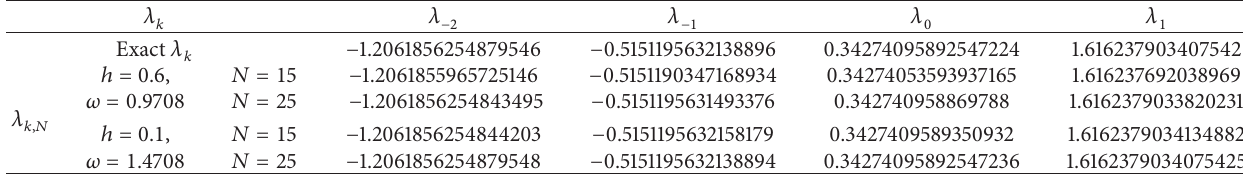
Table 1: The approximation 𝜆 𝑘,𝑁 and the exact solutions 𝜆 𝑘 for different choices of ℎ and 𝑁 .